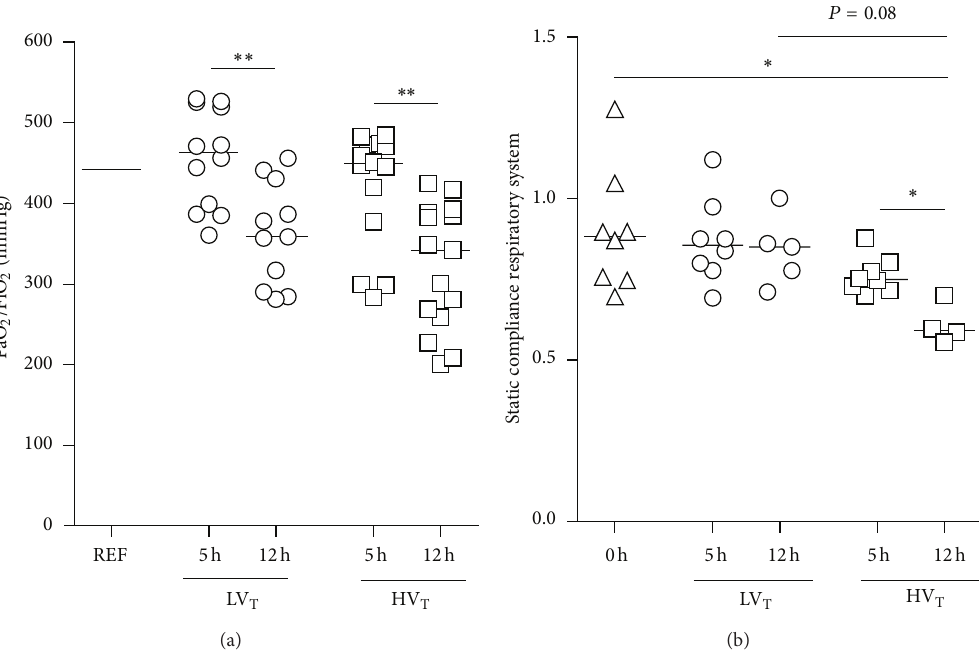
Figure 2: Respiratory parameters. Lung function is represented by the PaO 2 to FiO 2 ratio (PaO 2 /FiO 2 ) (a) and static compliance of the respiratory system (b). The reference (REF) represents the median PaO 2 /FiO 2 from 7 mice ventilated with LV T /PEEP for 30 minutes, that is, 442.4 mmHg (396.2 to 501.0) (a) or the combined static compliance of LV T /PEEP and HV T /ZEEP-ventilated mice at t = 0 h (b). The static compliance did not differ between the two groups at t = 0h. Data are presented as scatter plot (median) of 11–15 (a) or 4–8 (b) mice per group (triangle = REF; circle = LV T ; square = HV T ). ∗ Illustrates primary statistical analysis ( ∗ 𝑃 < 0.05 , ∗∗ 𝑃 < 0.01 ). NVC = nonventilated